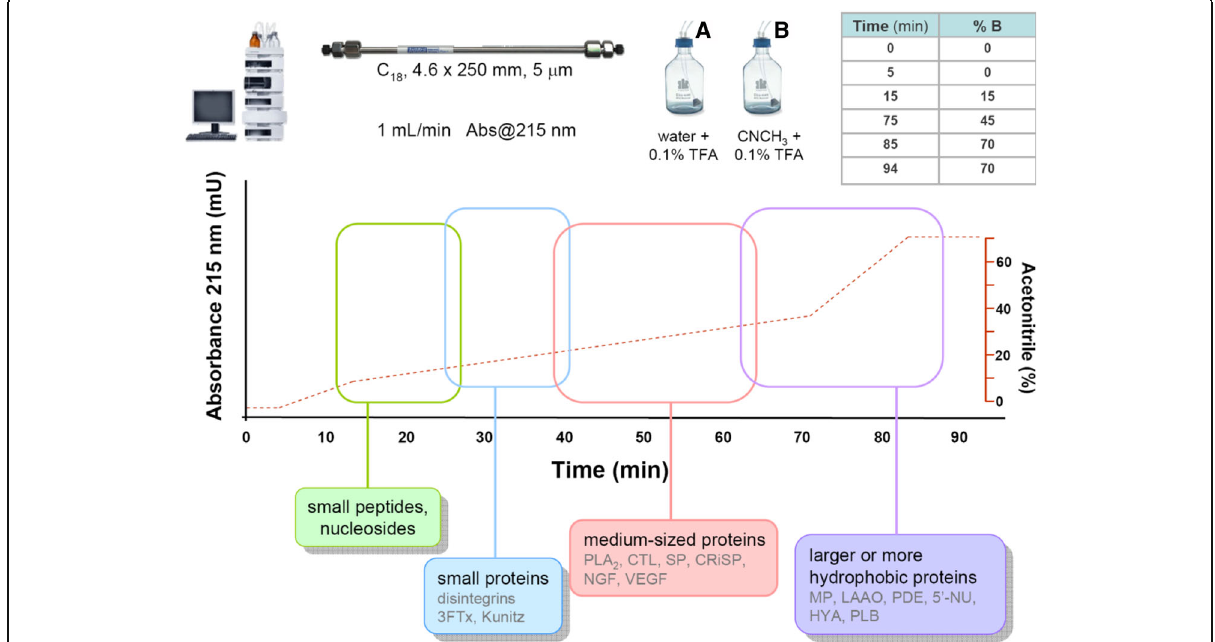
Fig. 2 Scheme for RP-HPLC fractionation of snake venoms. A considerable number of snake venomic studies have used the chromatographic conditions indicated in the diagram. The venom proteins are separated using an analytical (4.6×250 mm, particle diameter of 5 μ m) reverse-phase C 18 column, eluted at a flow rate of 1 mL/min by a linear gradient of water containing 0.1% of trifluoroacetic acid (TFA) (solution A) and 70% acetonitrile (CNCH 3 ) containing 0.1% TFAa, and the eluate monitored at 215 nm. The timetable for the mixing of these solutions (A, B), and the shape of the gradient (dashed line) are indicated. As an example, the approximate elution regions for some of the common protein components of snake venoms are indicated by colored boxes. This procedure has been applied to venoms of a number of viperid and elapid snakes, helping in the standardization and comparability of results between different laboratories. 3FTx: three-finger toxin; Kunitz: Kunitz-type serine protease inhibitor; PLA 2 : phospholipase A 2 ; CTL: C-type lectin; SP: serine protease; CRiSP: cystein-rich secretory protein; NGF: nerve-growth factor; VEGF: vascular endothelium growth factor; MP: metalloproteinase; LAAO: L-amino acid oxidase; PDE: phosphodiesterase; 5 ′ -NU: 5 ′ -nucleotidase; HYA: hyaluronidase; PLB: phospholipase